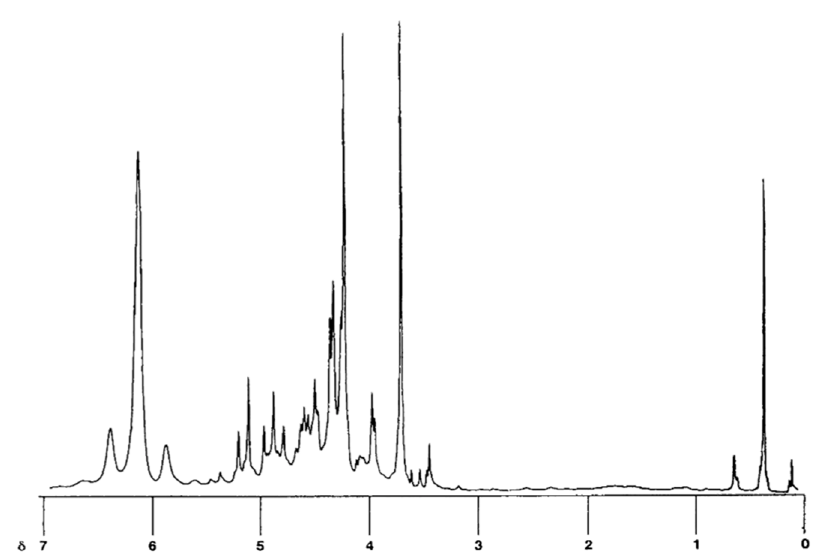
Figure 5. 1 H NMR spectrum of alfalfa-derived saponins.